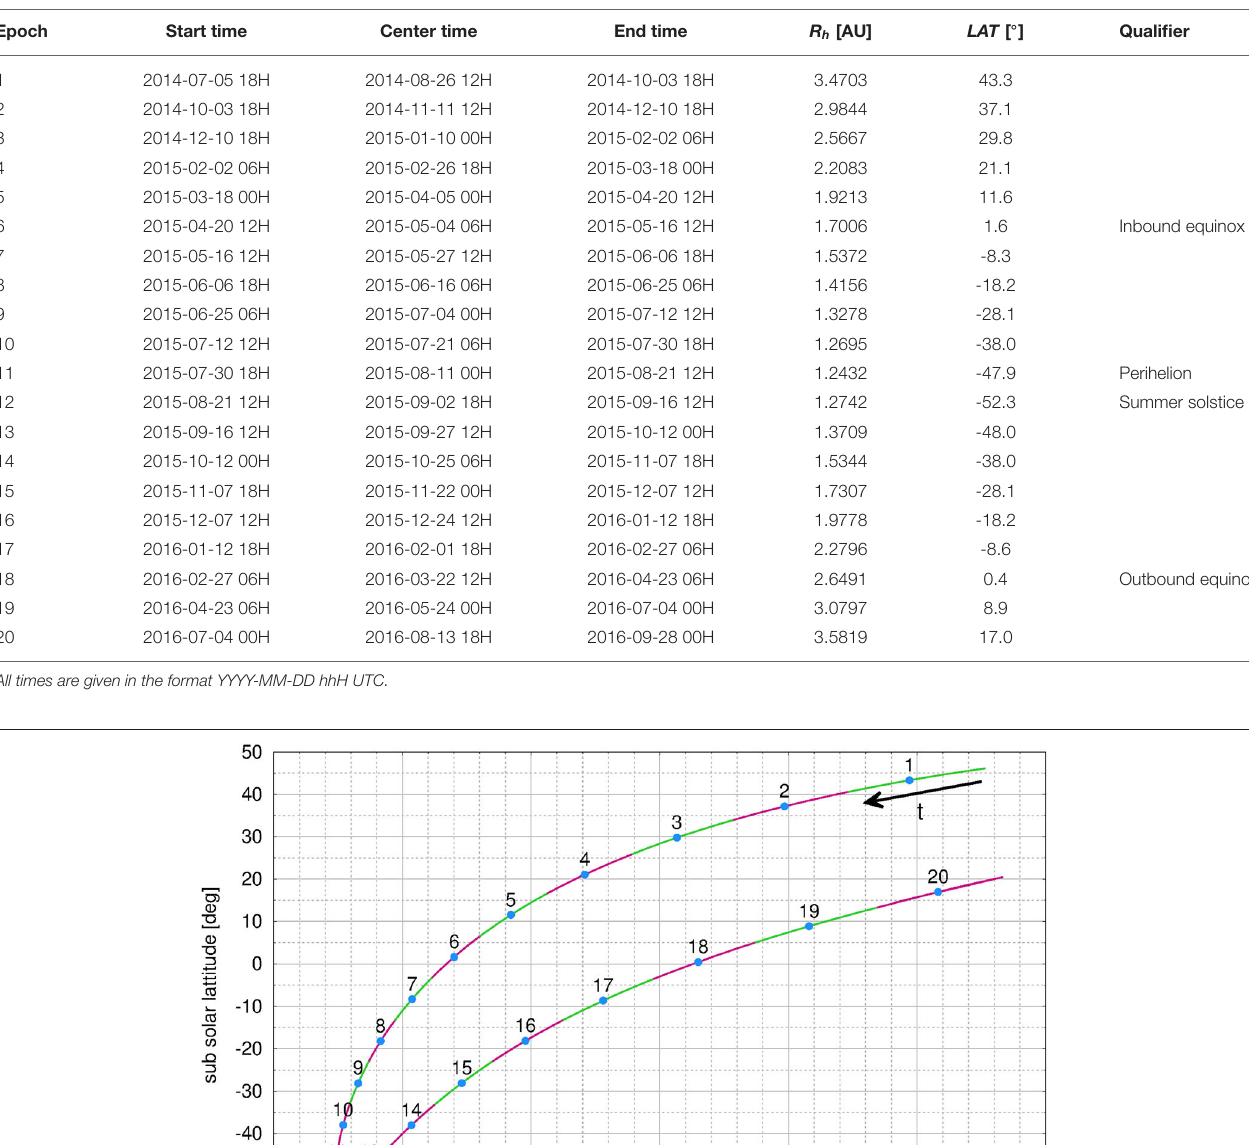
needed for a specific sublimation flux. In general though it is not a physical parameter and should not be interpreted as such. In the next steps, we calculate the gas and dust flow fields in three dimensions. We then perform a column integration along the line-of-sight through the dust coma for a specific viewing geometry of the OSIRIS NAC (narrow-angle) and WAC (wide- angle) cameras [14] and convolve the dust column densities with